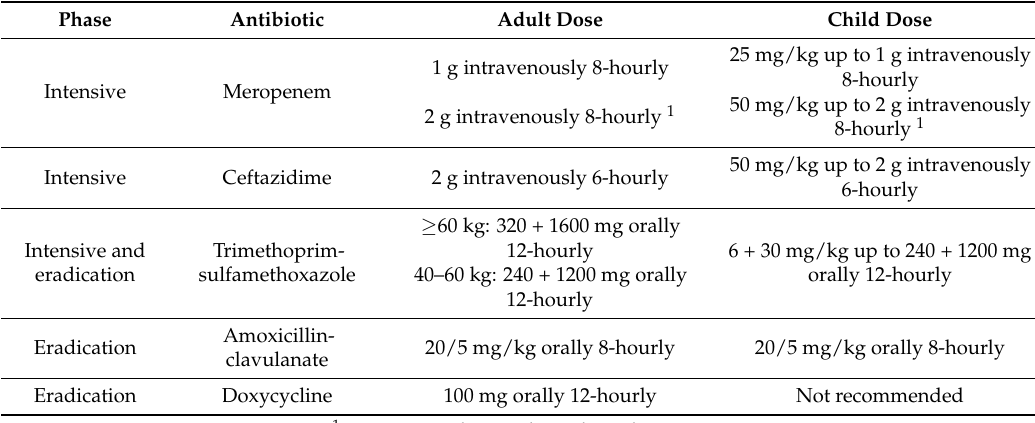
Table 1. Antibiotic dosing for treatment of melioidosis in Australia.